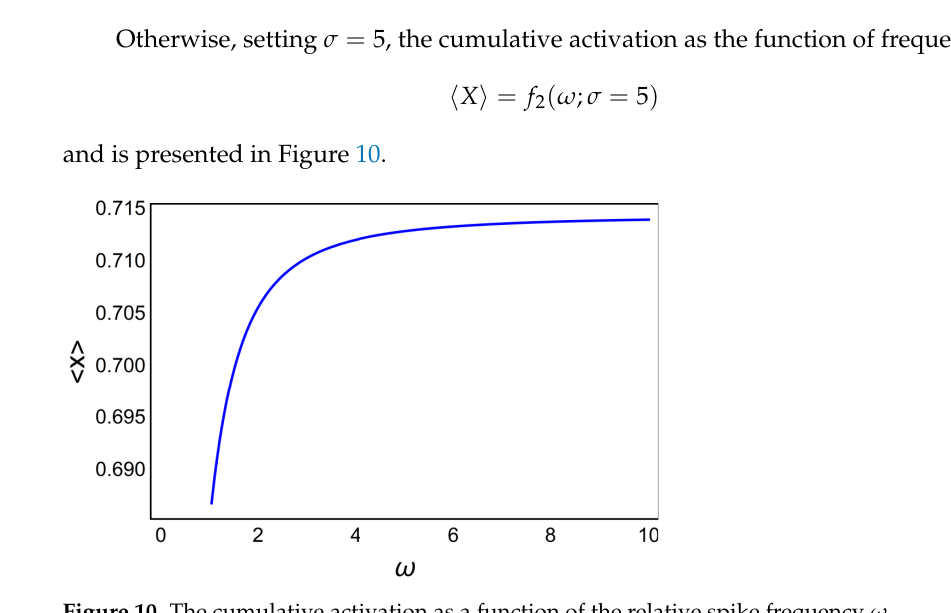
Figure 10. The cumulative activation as a function of the relative spike frequency 𝜔 .